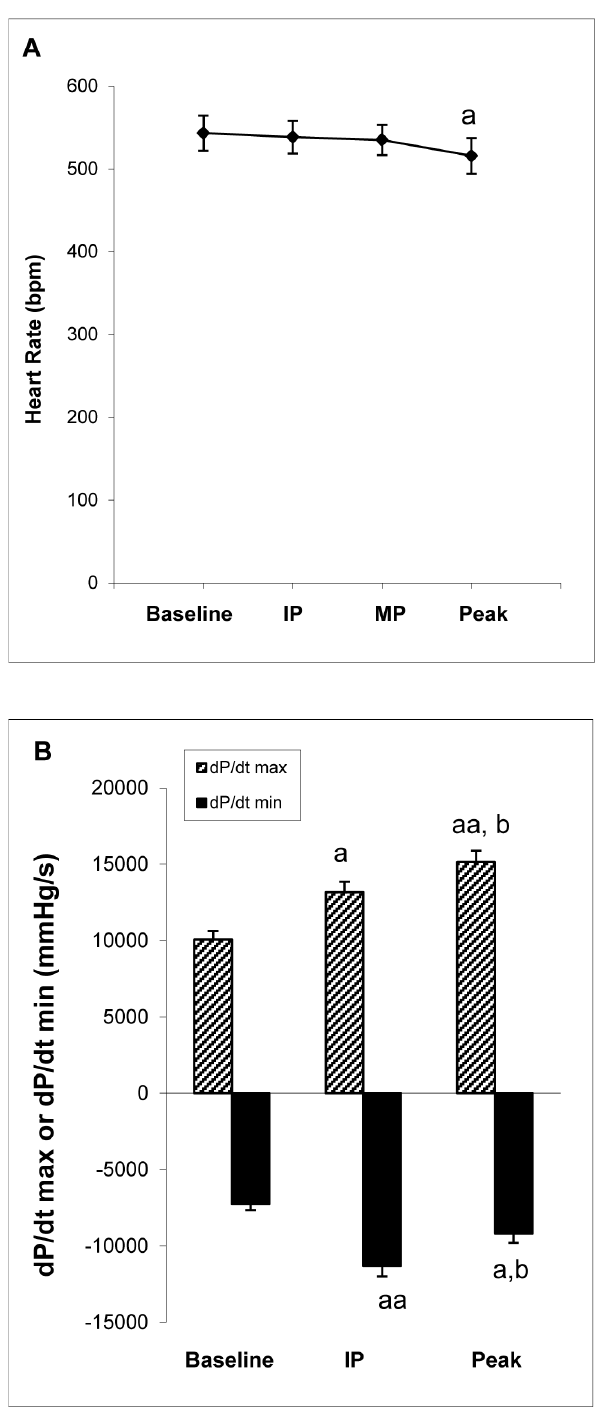
Figure 5. Changes in heart rate, dP/dt max, and dP/dt min with phenylephrine injection. (A): Heart rate before phenylephrine injection (baseline), at Inflection Point (IP), at middle point of phase II (MP), and at the maximum effects of phenylephrine (Peak). (B): dP/dt max and dP/dt min before phenylephrine injection (baseline), at inflection point (IP), and at the maximum effects of phenylephrine (Peak). a, aa: p , 0.05 or p , 0.01 versus baseline; b: p , 0.05 versus IP. IP: inflection point; MP: middle point.